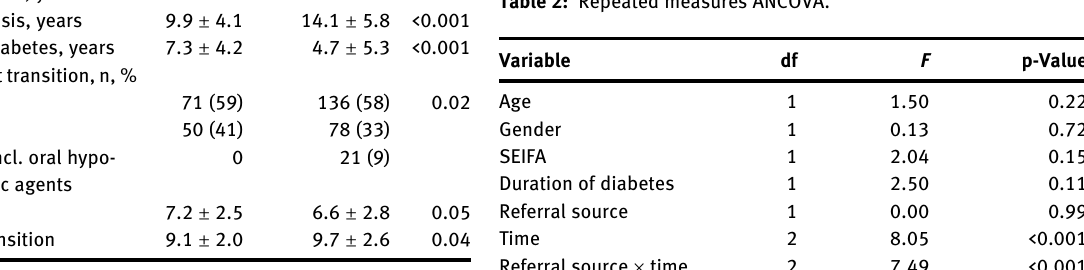
Table  : Repeated measures